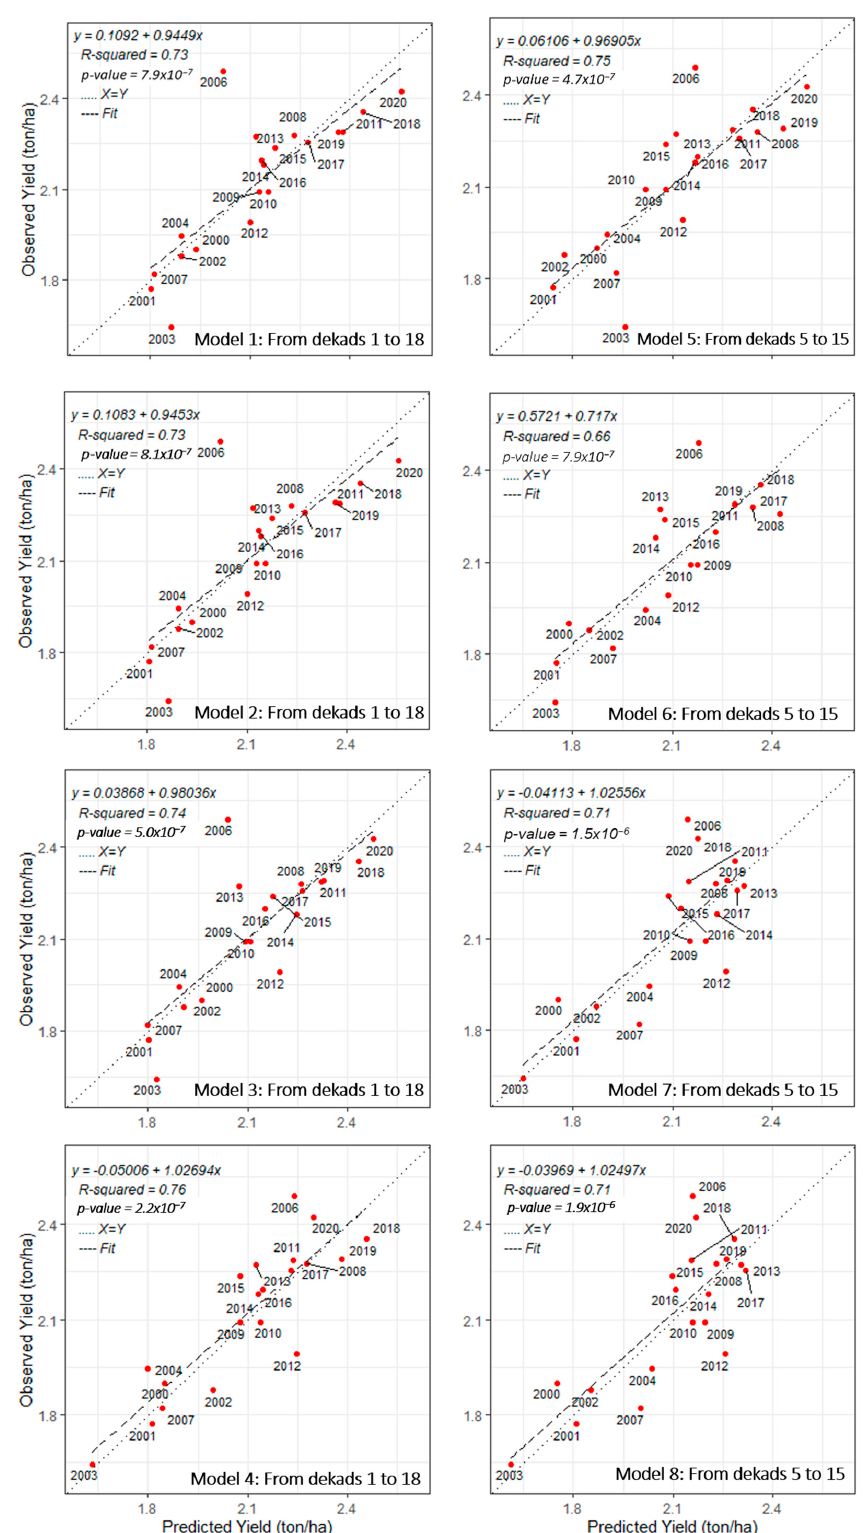
Figure 7. Scatter plot of observed versus model-predicted coffee yields for the years 2000 to 2020 using the eight best selected models based on satellite data for the period from dekads 1 to 18 (models 1 to 4) and for the period from dekads 5 to 15 (models 5 to 8). For model 6, the predicted value for the year 2020 is 3.0 ton/ha, which is outside the plot frame. R-squared and p -values reported in this figure are those of the relation between observed versus predicted yield for the full 2000–2020